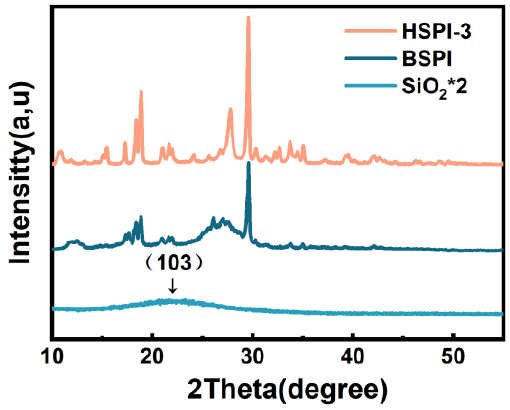
Figure 1. XRD patterns of the prepared SiO 2 , BSPI, and HSPI-3 samples.